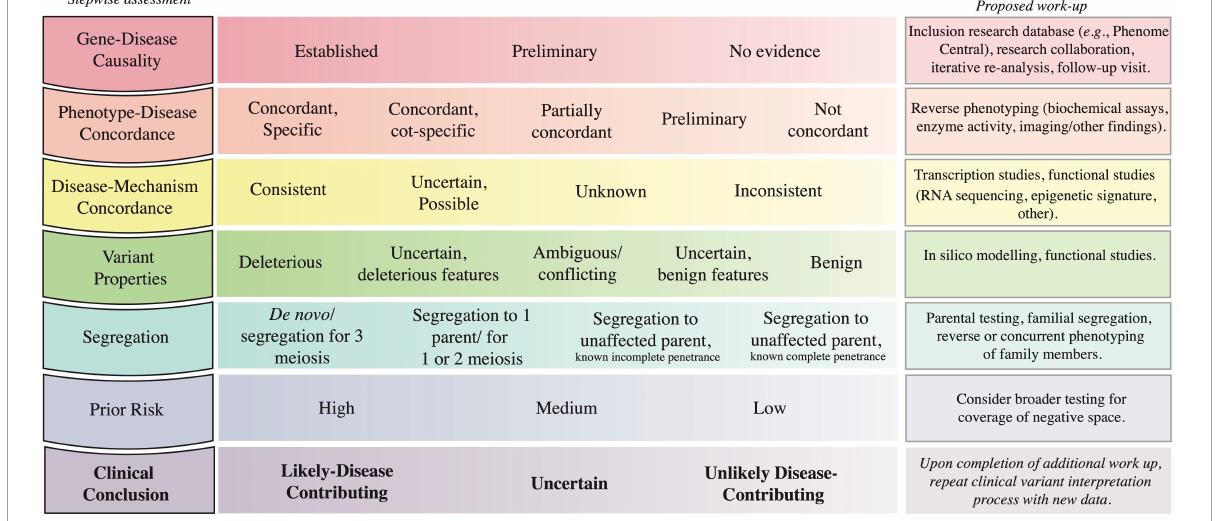
FIGURE5 Clinical variant interpretation logic. The left column includes the key lines of evidence to consider in variant interpretation; it starts with assessment of gene-disease causality and progresses to the integration of prior risk. A detailed description of the principles establishing gene-disease association, phenotype-disease concordance, disease-mechanism concordance, and variant deleteriousness, and a Clinical Variant Analysis Tool were reported previously to facilitate the capture and synthesis of these multiple lines of logic in assessing causality of variants (27). A depiction of how phenotype specificity informs the posterior probability that Variant A contributes to the patient presentation is presented in Supplementary material section 6 . The prior risk refers to the likelihood of the Disease A in the patient, as determined before the initiation of genomic testing ( Figure 3A ). The middle column lists possible assignments for each row; the left-most option is most supportive of variant contribution to disease, whereas the right-most option is least supportive of variant contribution to disease. The third column highlights methods that can be pursued to collect further evidence to inform the corresponding assessment. The last row denotes the clinical conclusion based on the integration of the other rows